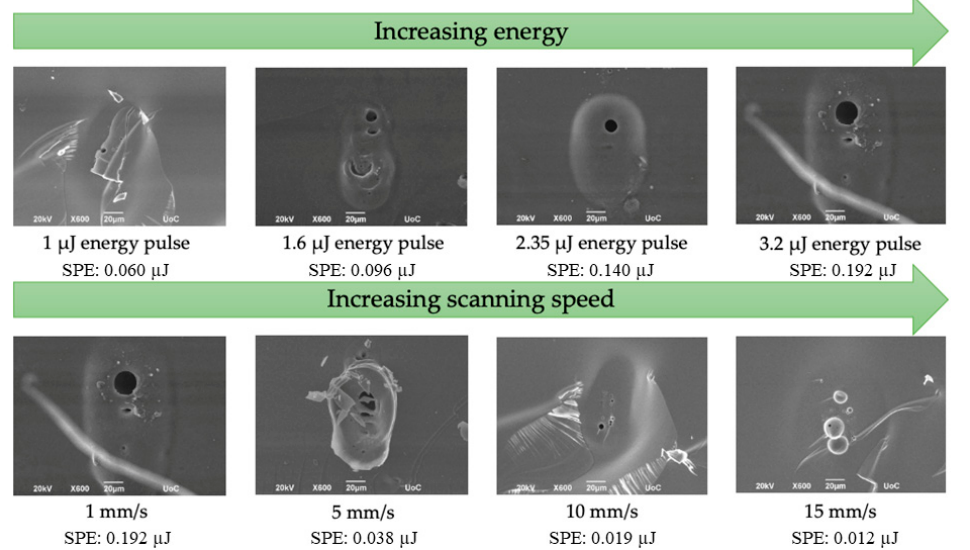
Figure 4. SEM images from the cross-section of processed phosphate glasses. Top line shows the effect of increasing optical energy at a constant scanning speed of 1 mm s − 1 , while the bottom line depicts the effect of the increasing inscription scanning speed keeping constant the energy of the incident laser pulses at 3.2 µ J. The specific point energy (SPE) values are also